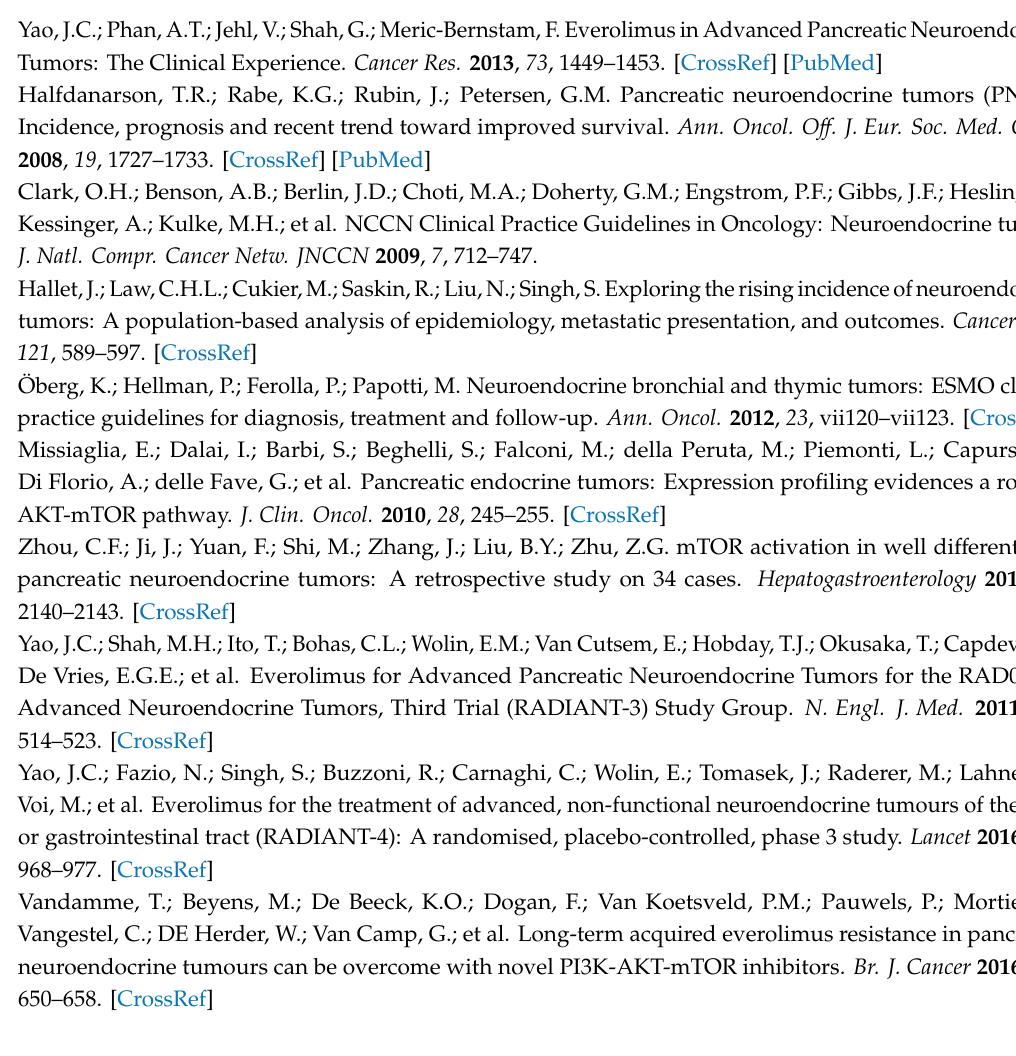
Figure S1: Cell proliferation of three individual PA-NETs, Figures S2–S5: Unprocessed images for WB results, Table S1: Pathological Findings of PAN-NETs and PNTs included in the